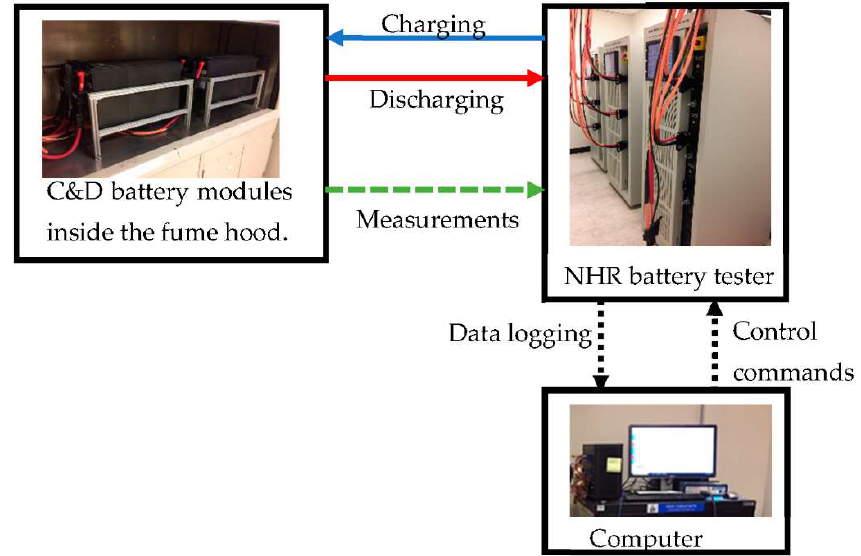
Figure 1. Experimental setup of the BESS, comprising battery module DC storage, and battery tester representing the grid and site controller.